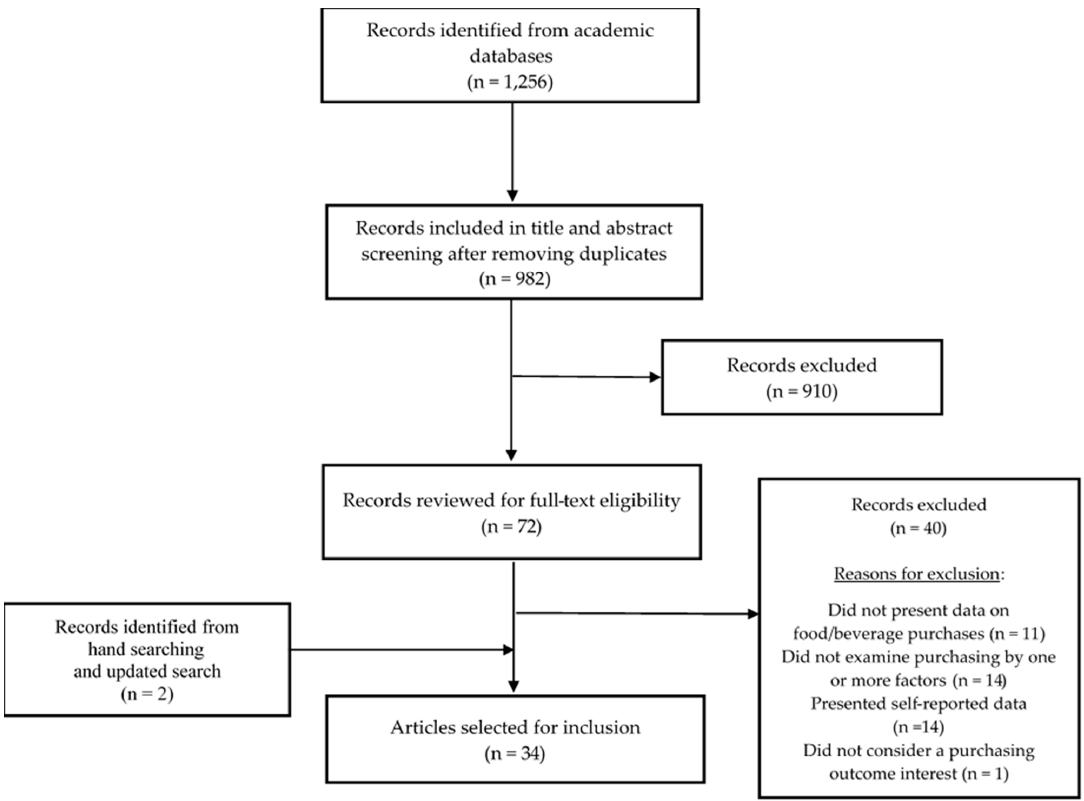
Figure 1. Flow chart for scoping review.